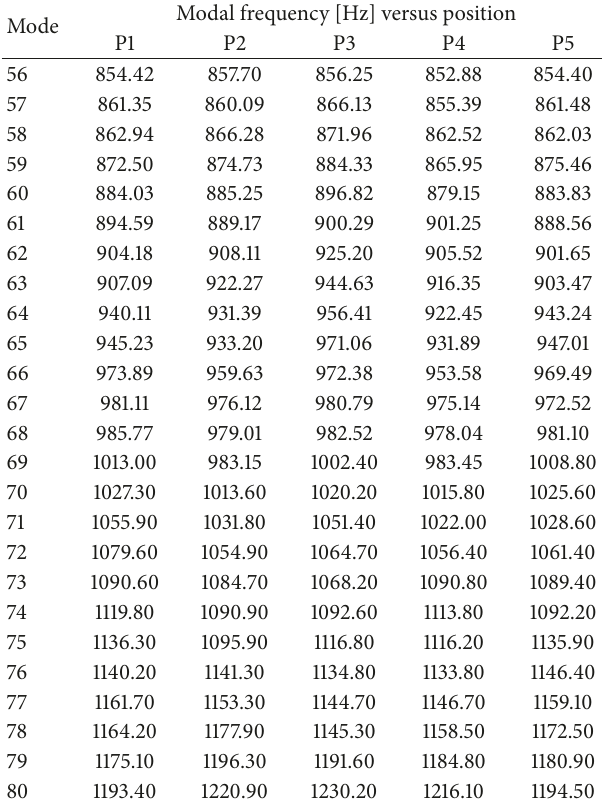
Table 1: Vibration modes and modal frequencies for the various configurations of the